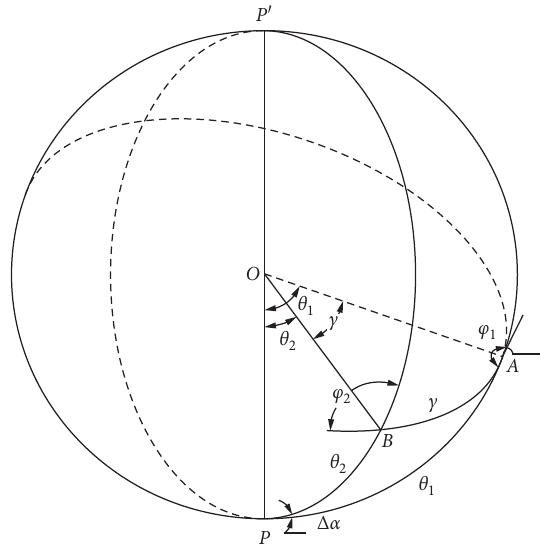
Figure 1: Mapping of incline-measure data in a spatial spherical